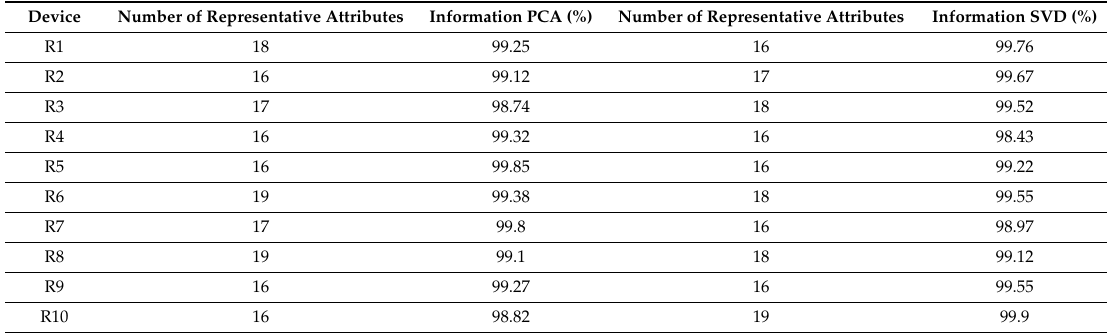
Table 8. Number of representative